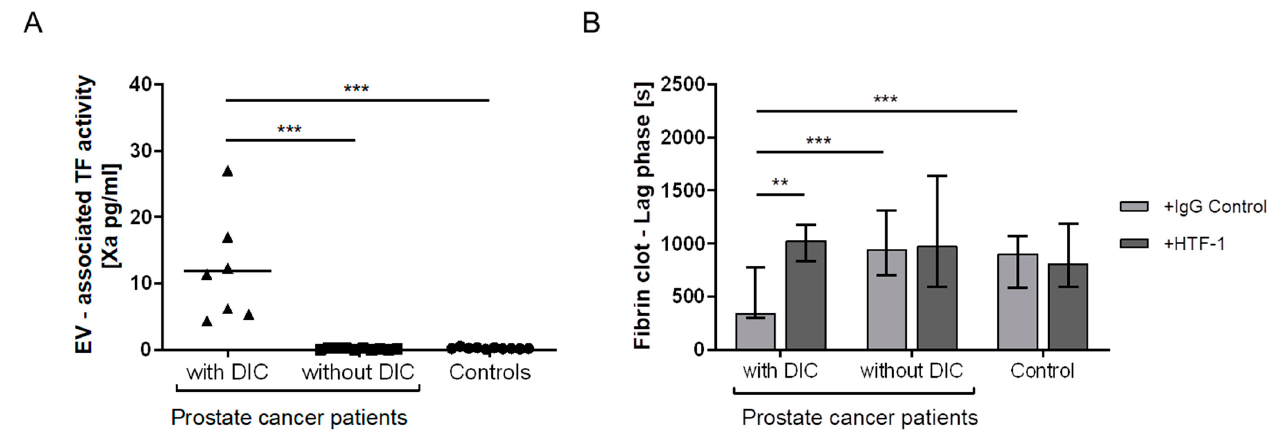
Figure 3. Analysis of the EV-TF activity and EV-TF-dependent fibrin clot formation. EV-TF activity was elevated in patients with prostate cancer and DIC compared with patients with prostate cancer without DIC and healthy controls ( A ). Only EVs from prostate cancer patients with DIC shortened the clotting time of EV-depleted normal-pooled plasma in a TF-dependent manner ( B ). In Figure 3A, each triangle or dot represents a measurement of a single patient, and the line represents the median. Figure 2B shows a bar blot representing the median and whiskers representing the range. (** p ≤ 0.01, *** p ≤ 0.001, Wilcoxon–Mann–Whitney U-Test). Abbreviations: TF—tissue factor; HTF-1—human tissue factor 1 blocking antibody.